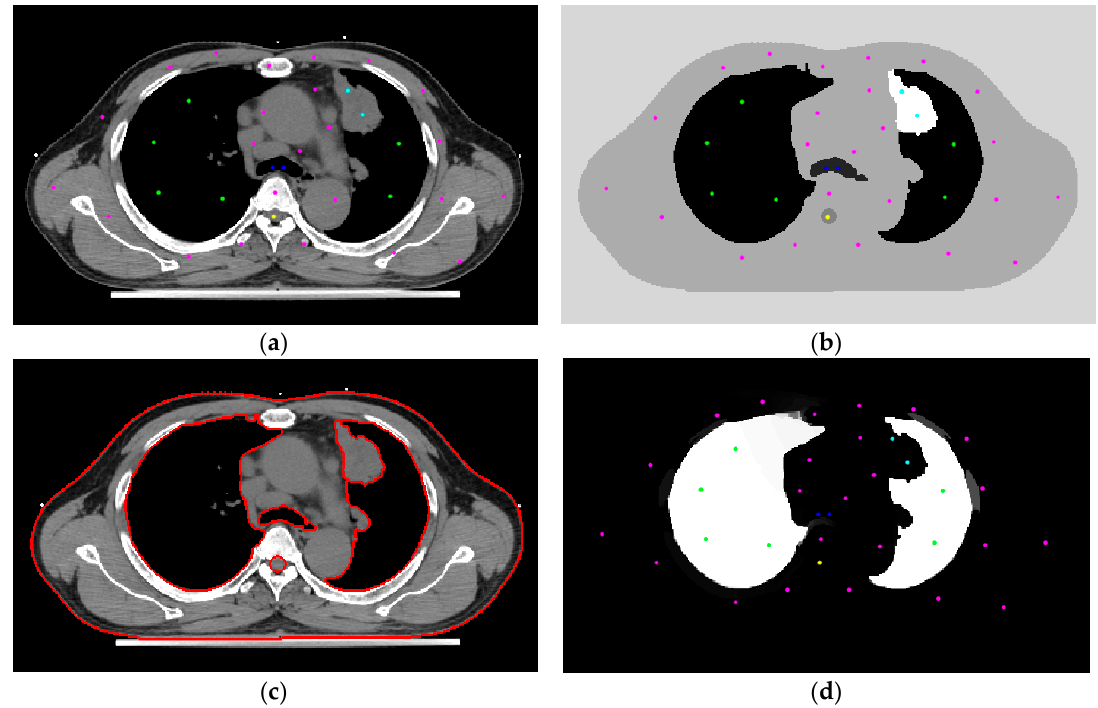
Figure 2. ( a ) The raw image with some initial seeds. ( b ) The RW segmentation result. ( c ) The automated delineations superimposed on the raw image. ( d ) The segmented lung area with seeds superimposed on the result.